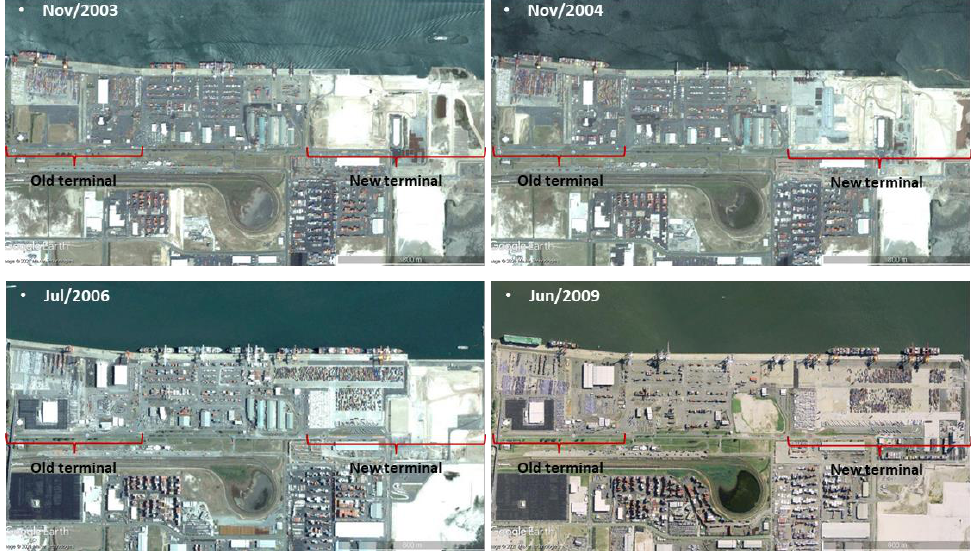
Figure 2. Greenfield-like implementation approach for new automated straddle carriers in the Fisherman Island Patrick Terminals, Australia.